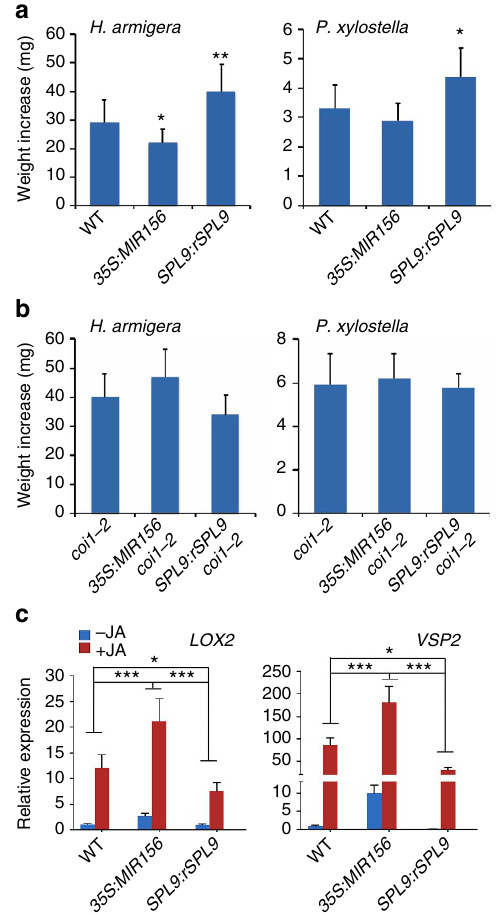
Figure 2 | SPL9 negatively regulates plant resistance to insect and JA response. ( a , b ) Weight increase of H. armigera and P. xylostella larvae fed with the indicated plant leaves, both insects gained higher weight from the SPL9:rSPL9 plants. Leaves from the B 30-day-old plants in SD were used in feeding. Data are means ± s.d. ( n ¼ 25), asterisks indicate a significant difference from the wild-type (WT) group (Student’s t -test, * P o 0.05, ** P o 0.01). ( c ) LOX2 and VSP2 expressions in plants over-expressing miR156 ( 35S:MIR156 ) or SPL9 ( SPL9:rSPL9 ). Plants (30-day-old in SD) were treated with 50 m M MeJA ( þ JA) or ethanol ( (cid:2) JA) as control, and 4h later the transcript levels in new leaves of the indicated plants were detected by qRT-PCR. The expression in the wild-type was set to 1. Data were analysed by multiple comparisons (Tukey test) followed by two-way ANOVA (* P o 0.05, *** P r 0.001). Error bars represent ± s.d. ( n ¼ 3). ANOVA, analysis of